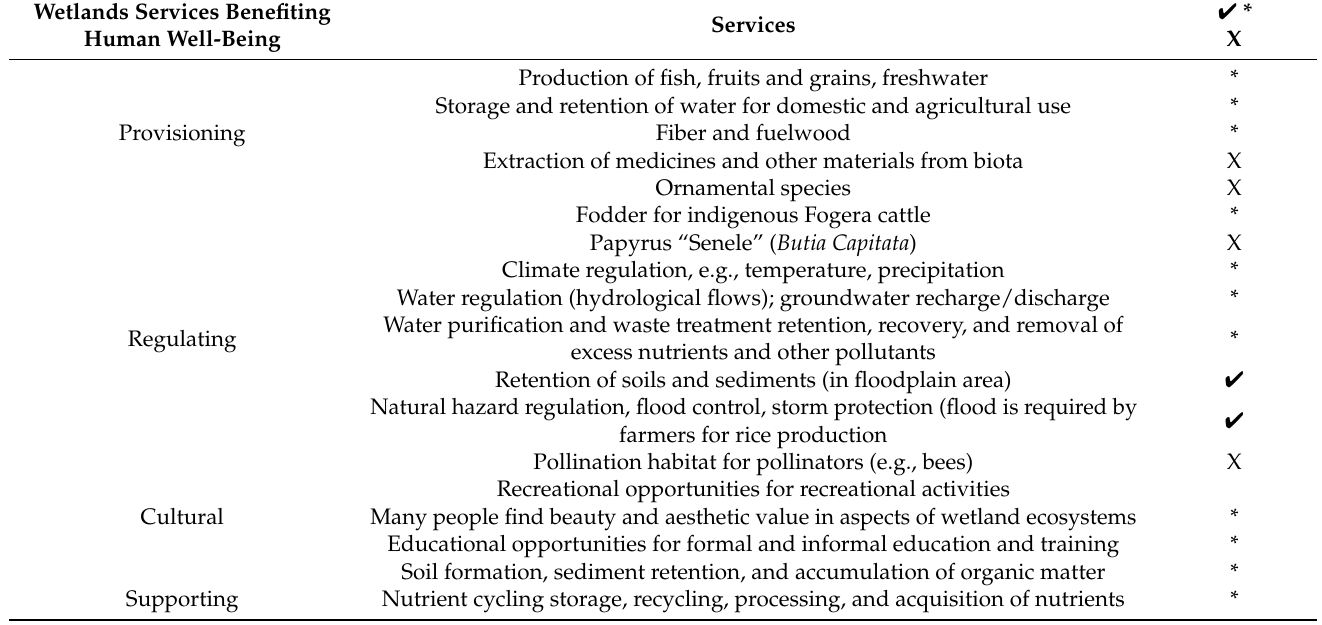
Table 8. Ecosystem services provided by or derived from wetlands that benefit human